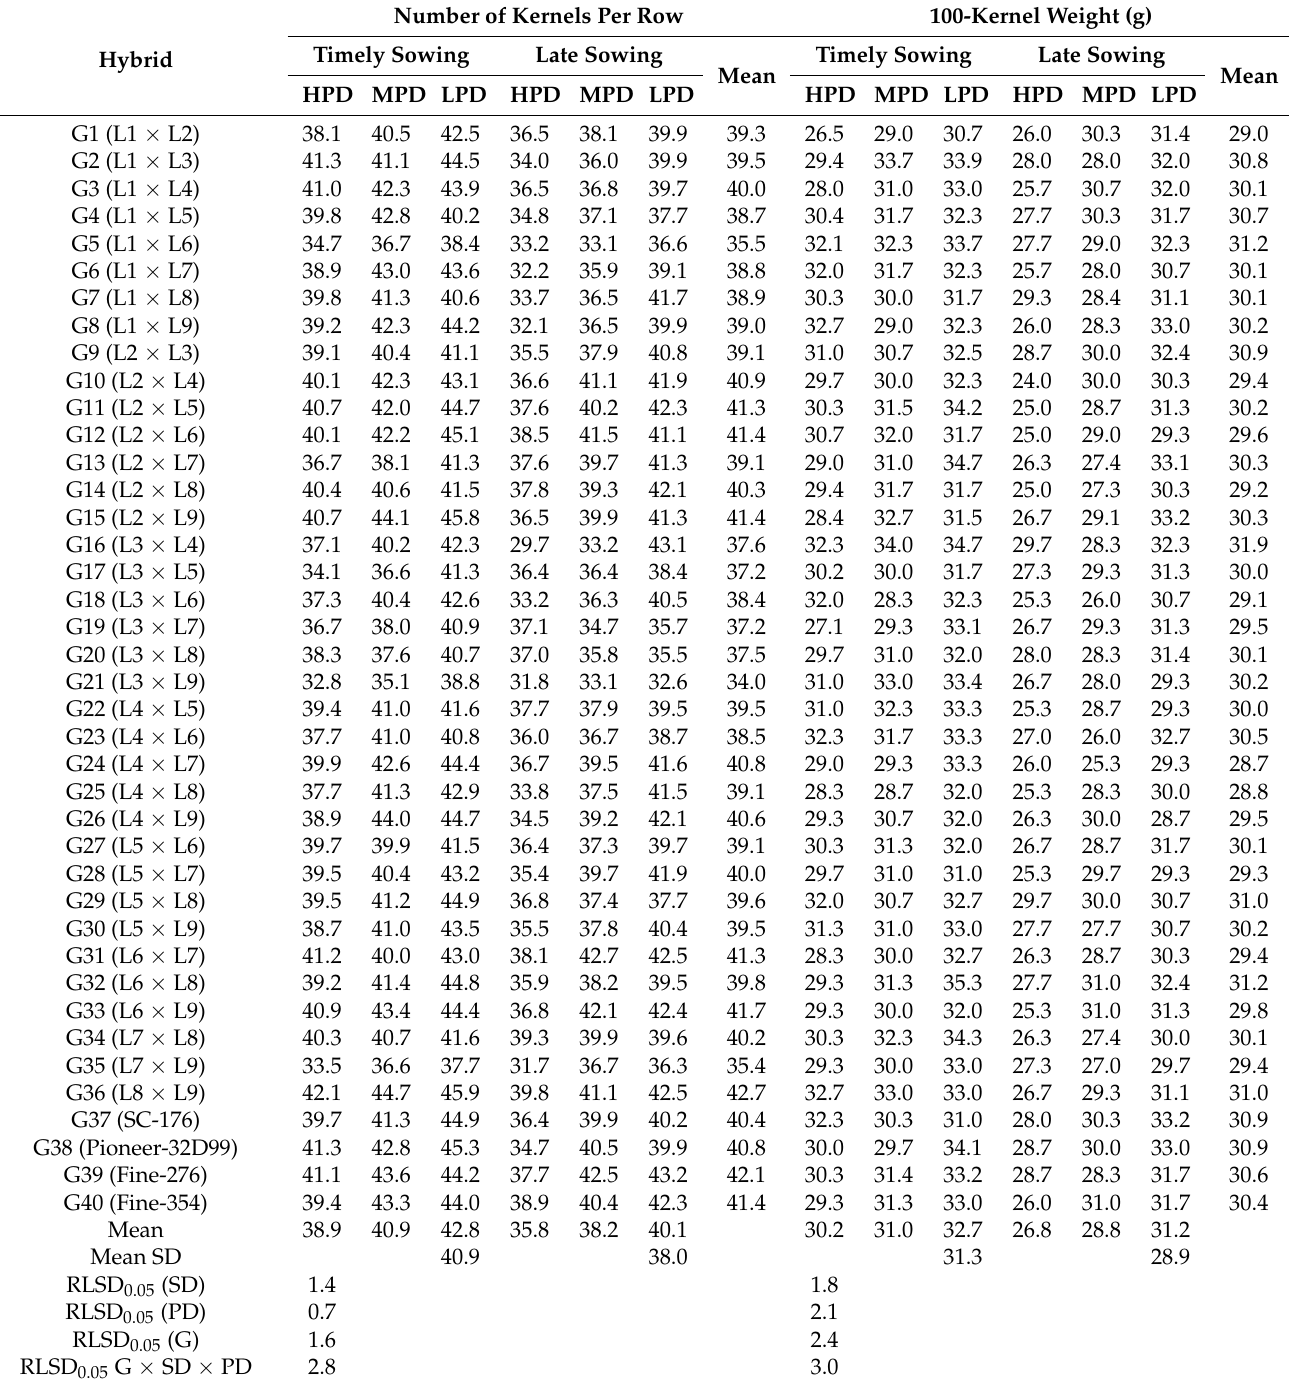
Table 3. Impact of sowing date and planting density on the number of kernels/row and 100-kernel weight of the evaluated 40 maize